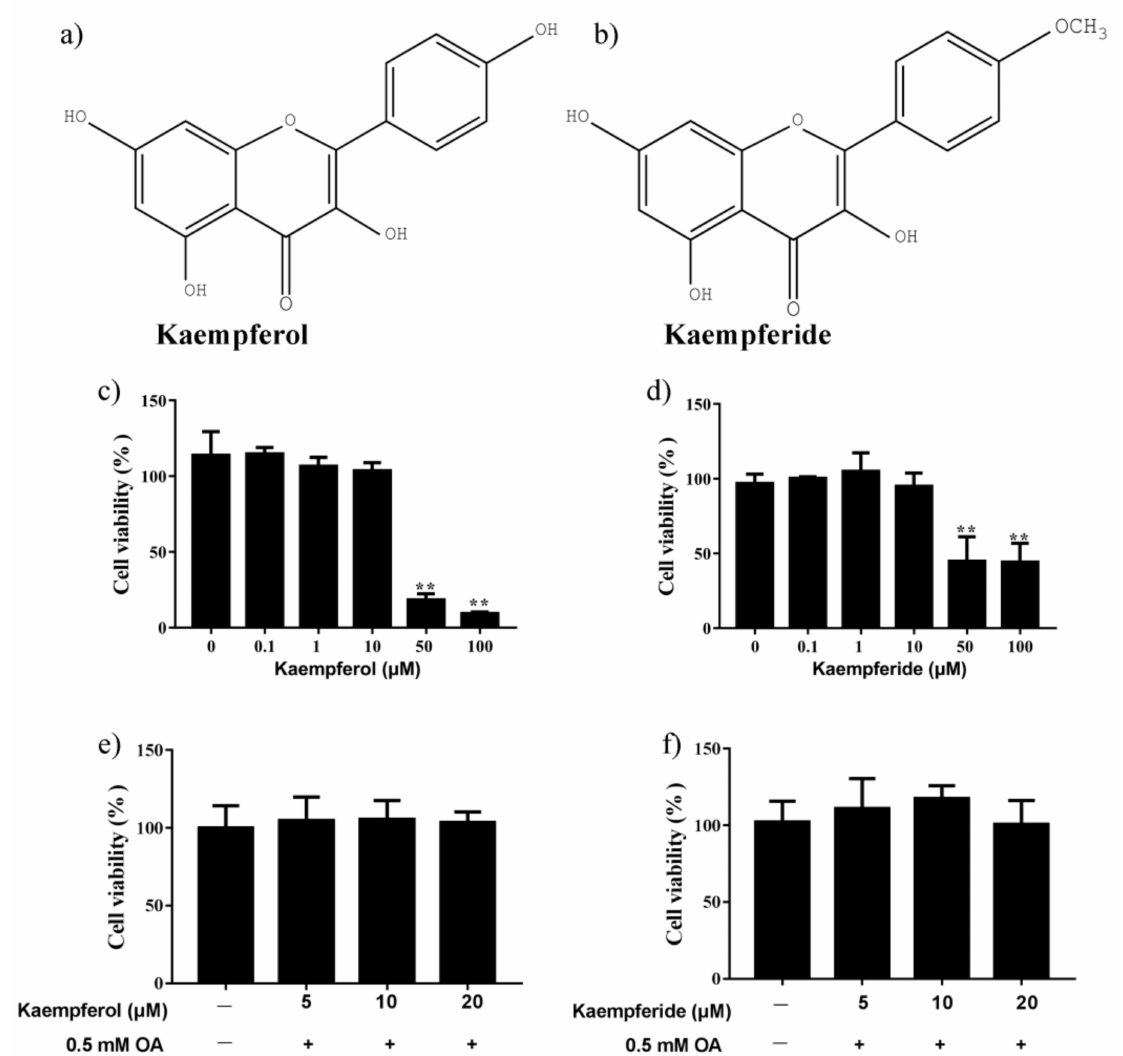
Figure 3. Changes in viability of HepG2 cells after incubation with kaempferol and kaempferide. ( a ) Chemical structure of kaempferol. ( b ) Chemical structure of kaempferide. ( c ) HepG2 cell viability after incubation with kaempferol. ( d ) HepG2 cell viability after incubation with kaempferide. ( e ) No change in HepG2 cell viability by co-incubation of OA and kaempferol for 48 h. ( f ) No change in HepG2 cell viability by co-incubation of OA and kaempferide for 48 h. Data were expressed as Mean ± SD of three independent experiments ( n = 3). ** p < 0.01, compared with vehicle-treated